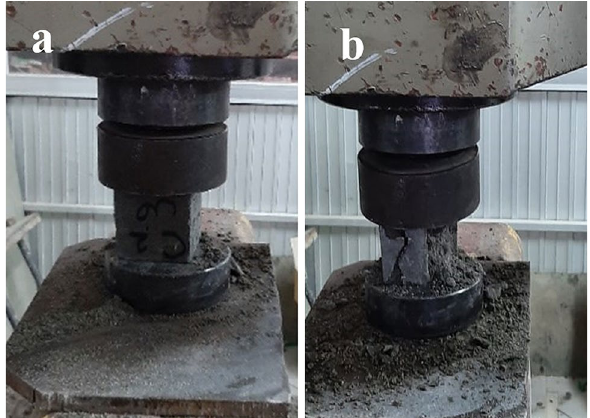
Figure 11. Compressing machine: ( a ) before testing and ( b ) after testing.